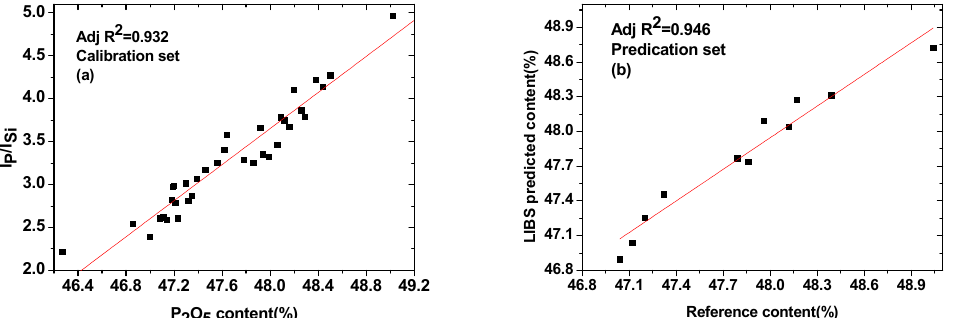
Figure 5. Internal standard method: ( a ) calibration curve using Si as an internal standardelement and ( b ) comparison of P content predicted by LIBS and the referencevalue (ICP).